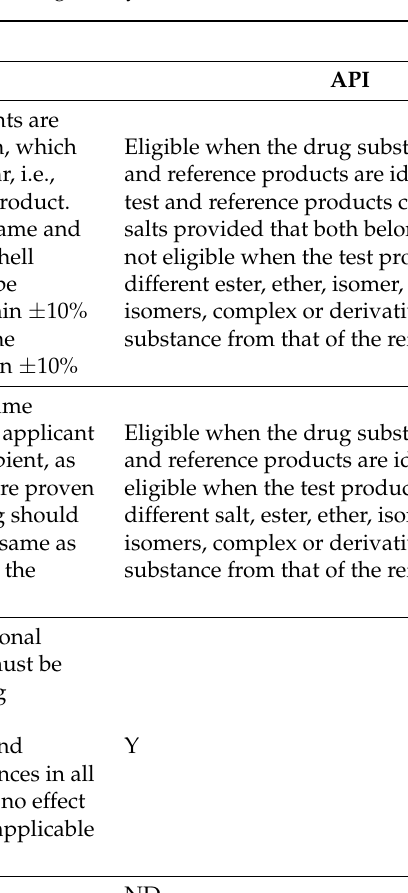
Table 5. Comparison of excipient, dosage form and API requirements between ICH and Latin American regulatory